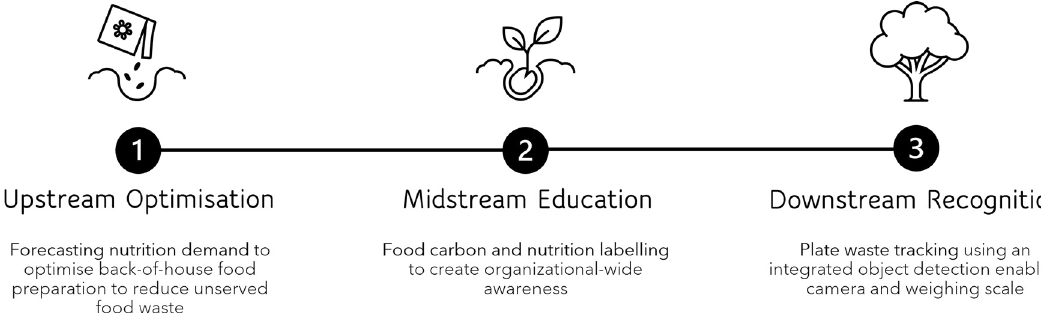
Figure 2. Three streams of decarbonisation for reducing life cycle GHG emissions from food waste: upstream optimisation, midstream education, downstream